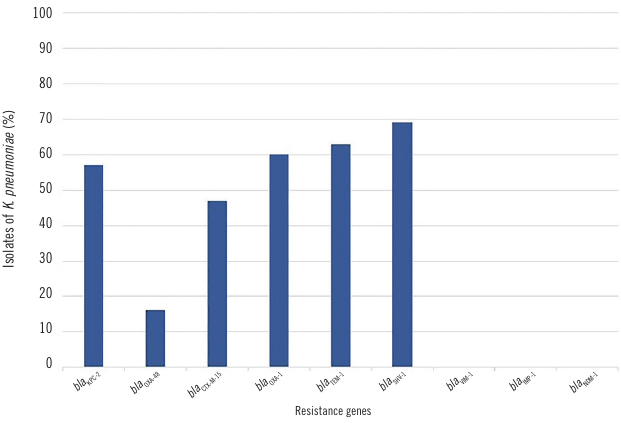
figurE 1 − Antimicrobial resistance in isolates of ESBL-producing K. pneumoniae ESBL: extended-spectrum